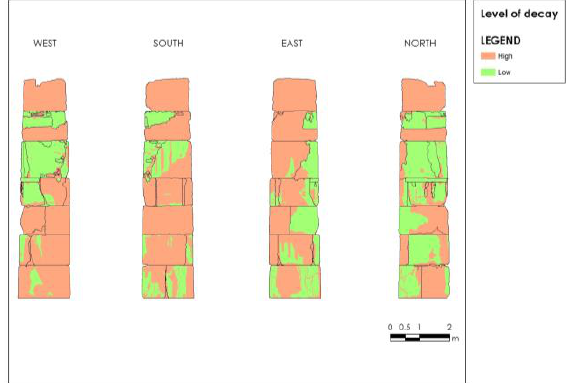
Figure 15: Thematic map of the level of decay (Orange: High level of decay; Light green: Low level of